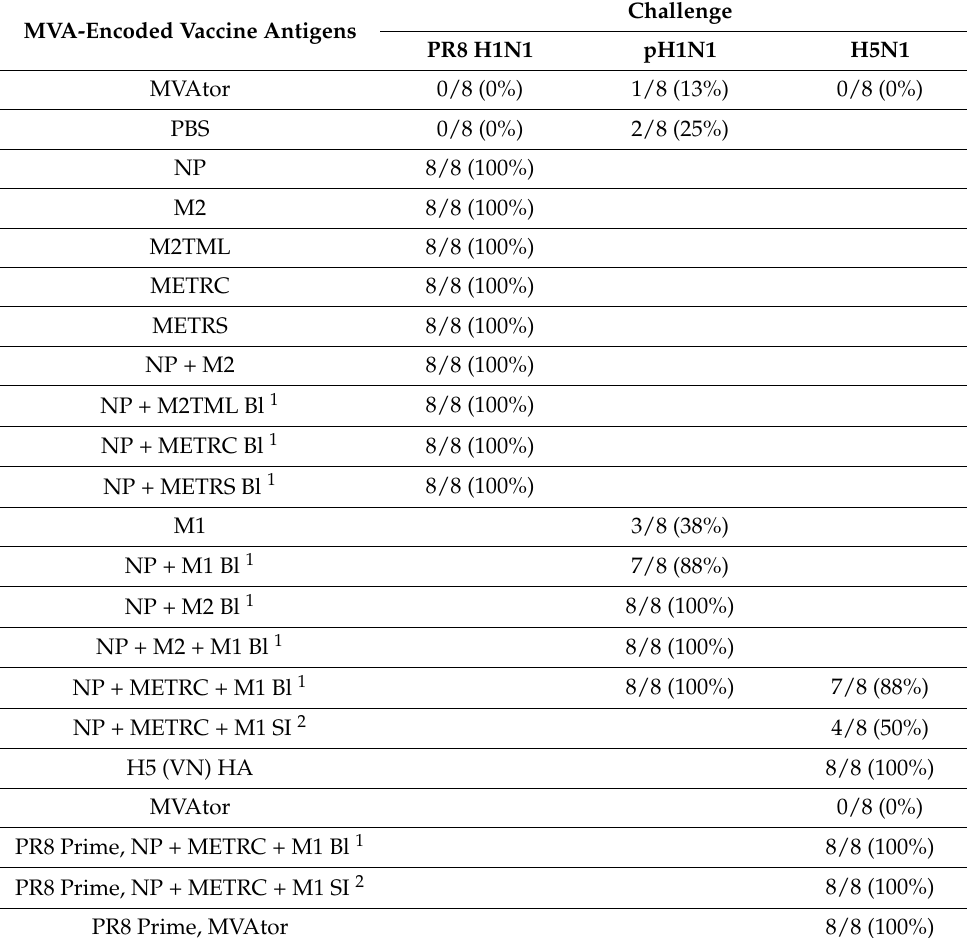
Table 1. Survival of influenza challenge after two immunizations. Numbers of survivors per group of 8 mice are listed as percent (%) survival. MVA-Encoded Vaccine